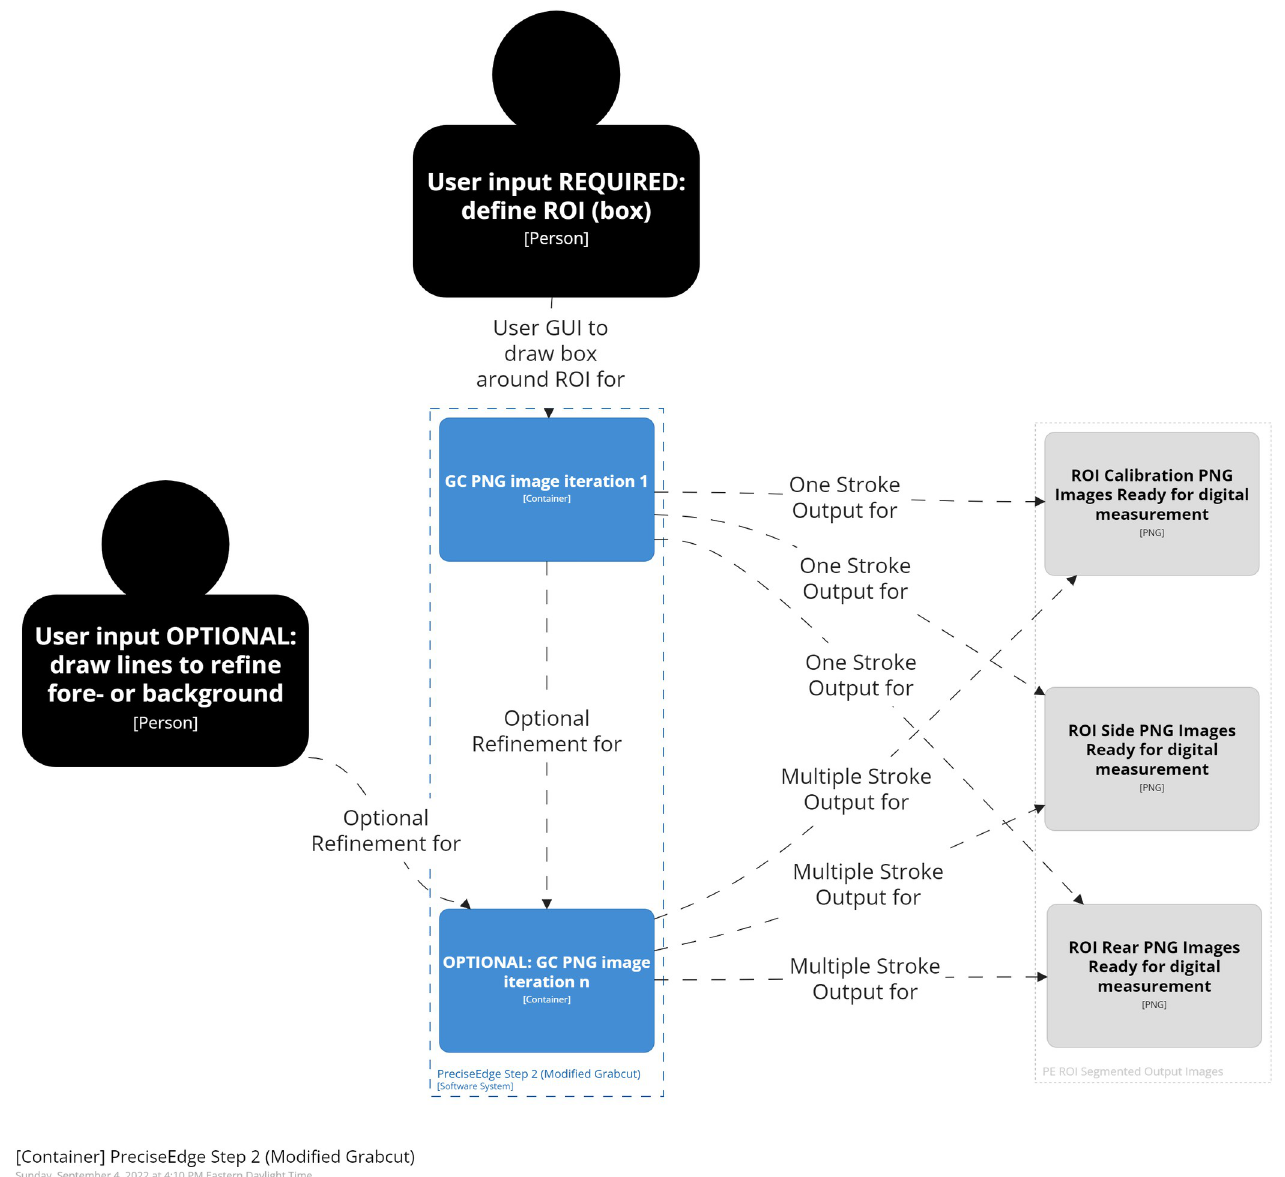
Fig 7. PreciseEdge algorithm step 2